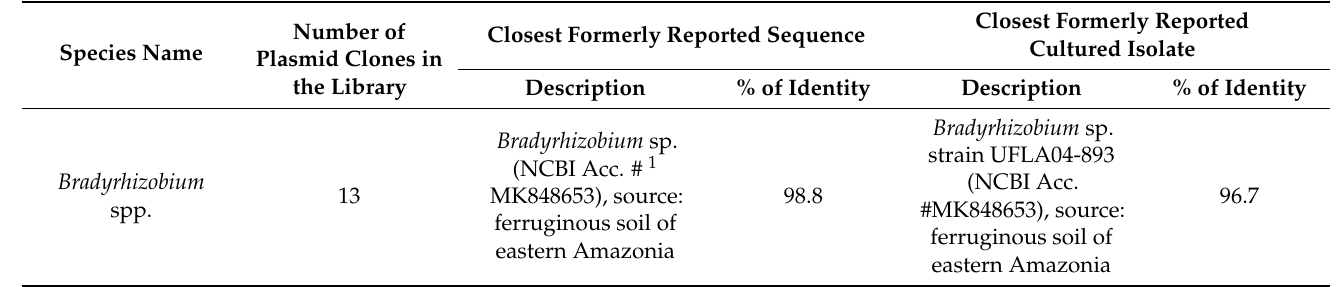
Table 3. The taxonomic lineage of non-cultured eubacteria from the water of Lake